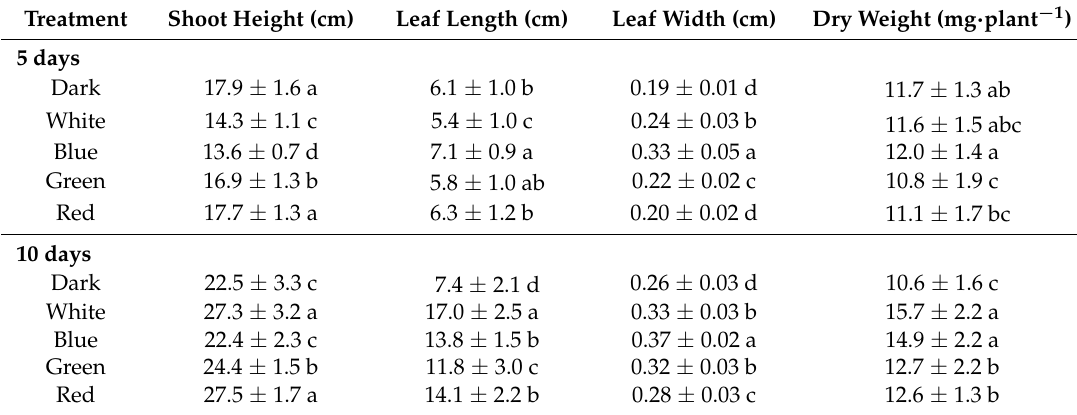
nm); R , red LED (620 650 nm). Table 1. Effect of LED lights on the morphological characteristics of rice seedlings after different wavelengths of LED illumination.